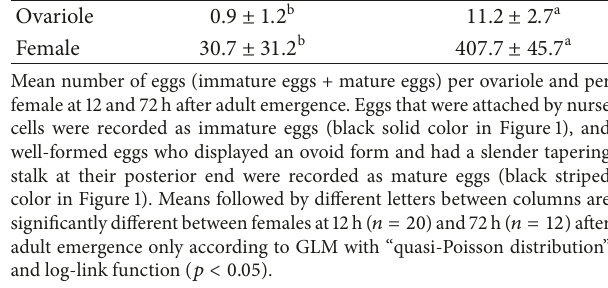
Figure 3: Variation of number of ovarioles in Therophilus javanus female ( 𝑛 = 31 ) depending on the host caterpillar age at time of parasitism (two-day-old caterpillars, three-day-old caterpillars, and four-day-old caterpillars).